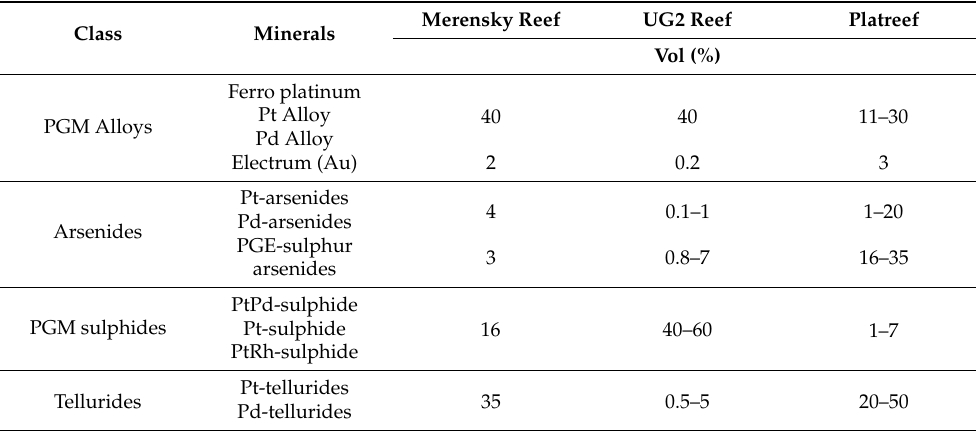
Table 4. PGM Mineralisation of the Merensky, UG2 and Platreef Ores